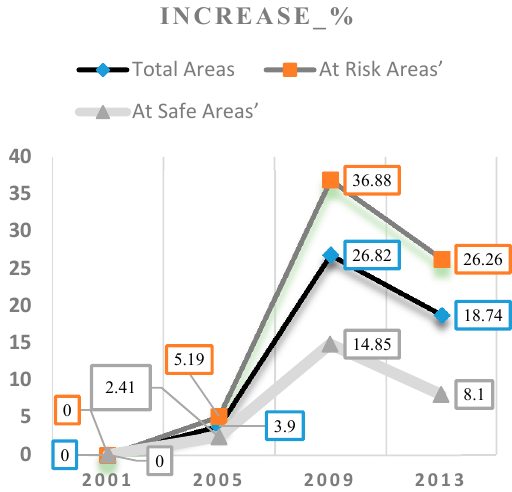
Figure 9. Proportion of safe and at risk areas developed according to year.